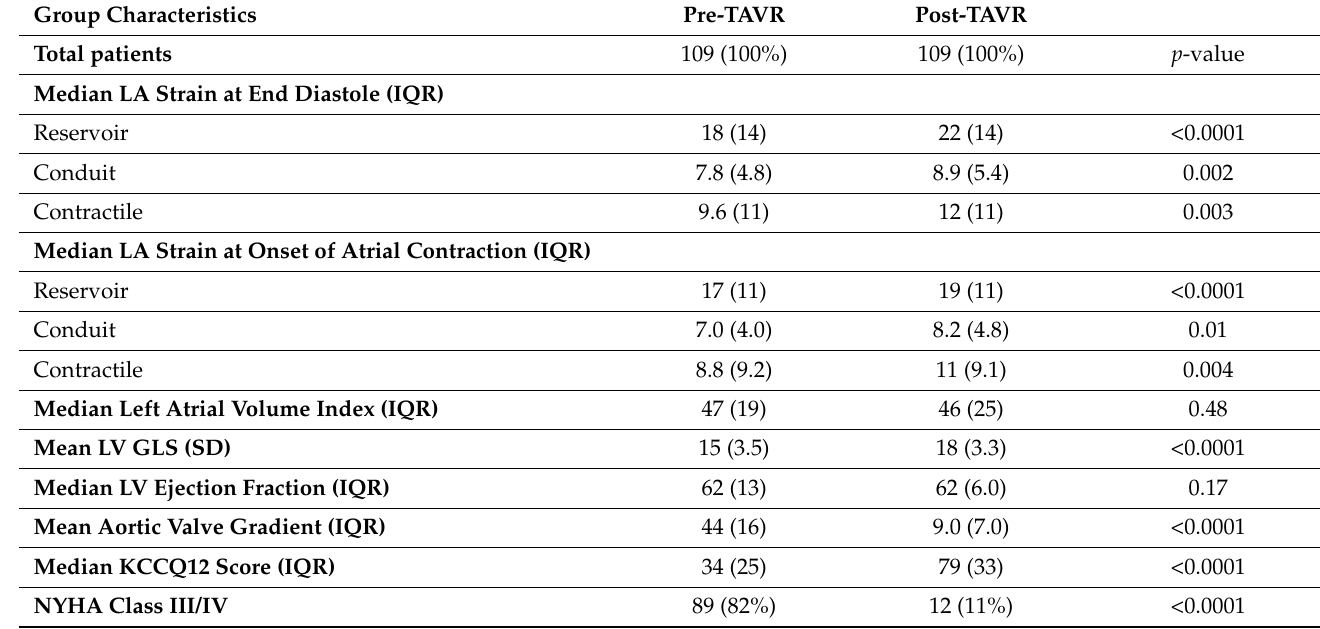
Table 3. Symptoms and echocardiographic parameters pre- and 30 days